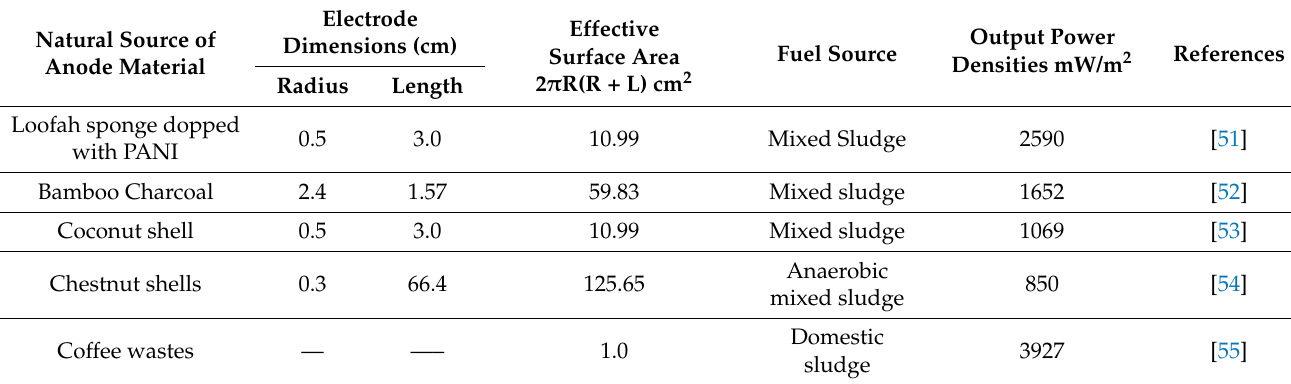
Table 2. Natural material-based anode and output